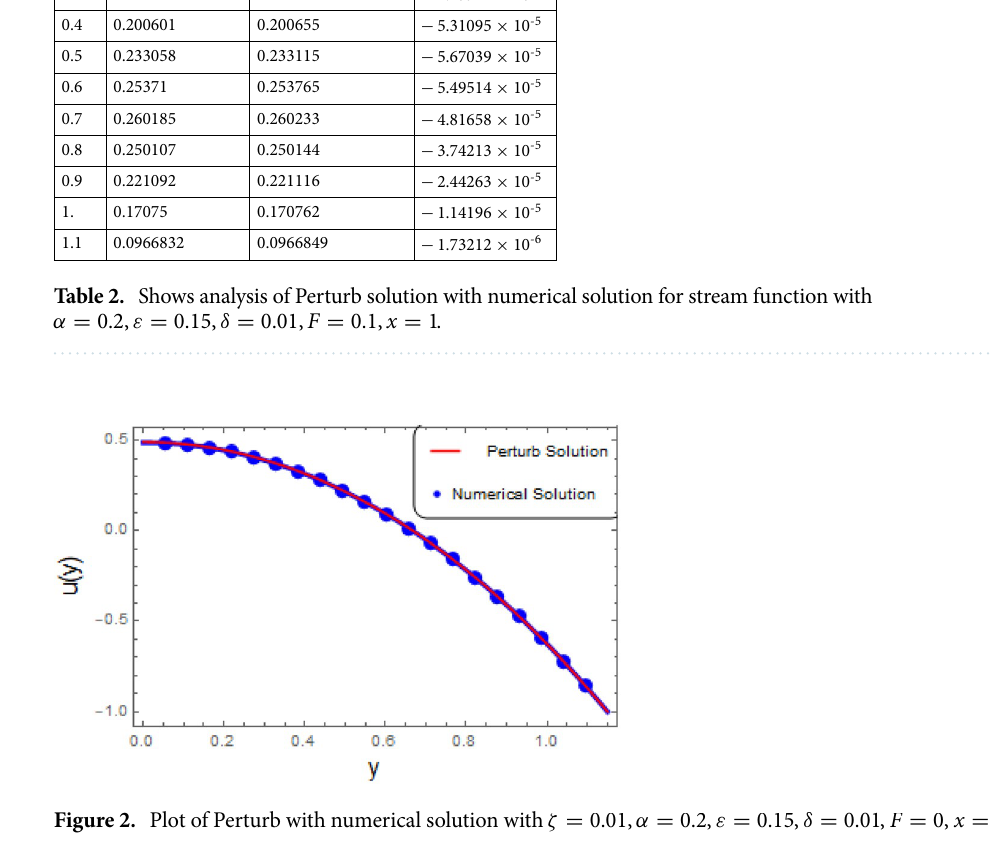
Figure 2. Plot of Perturb with numerical solution with ζ = 0.01, α = 0.2 , ε = 0.15 , δ = 0.01 , F = 0 , x = 1 .